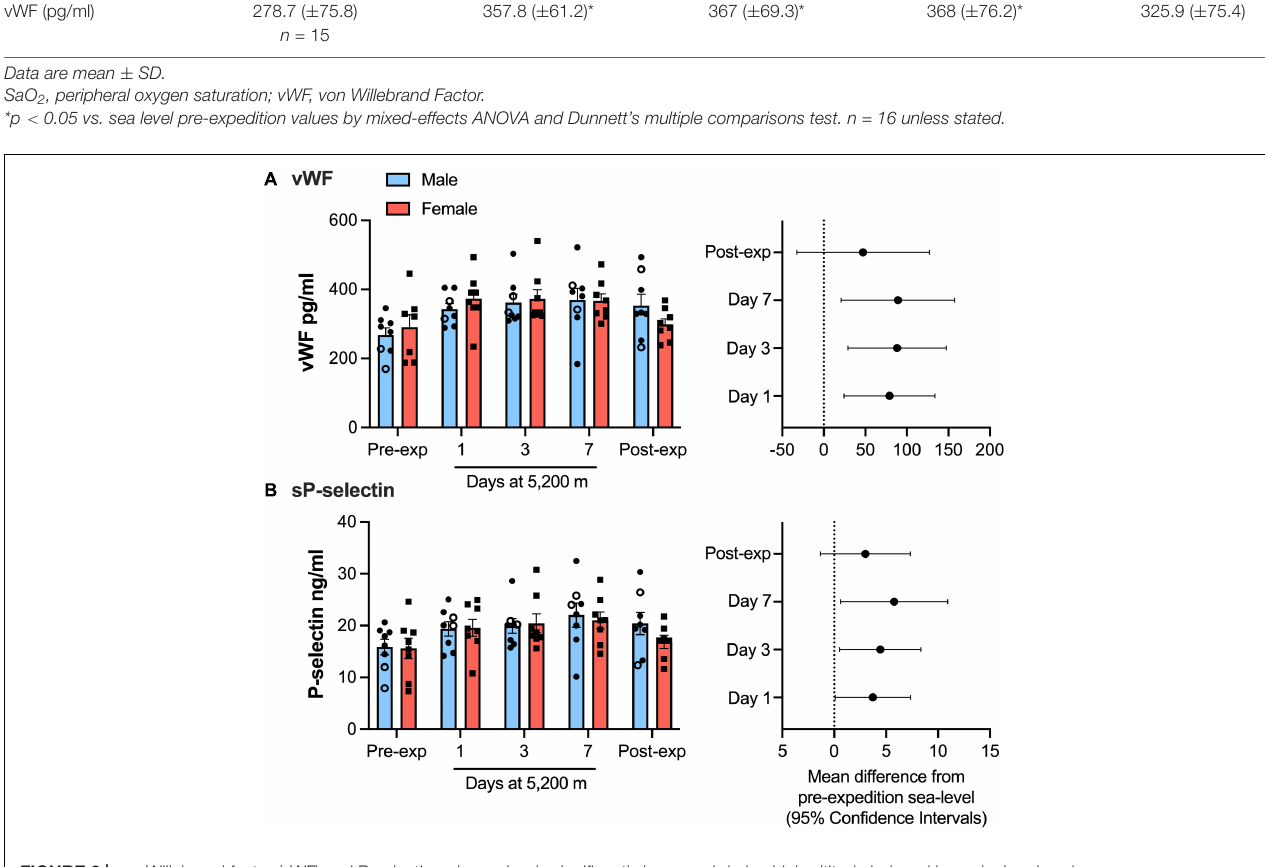
Plasma vWF significantly increased upon altitude exposure ( Figure 2 and Table 1 ) compared to pre-expedition sea-level values. sP-selectin was also significantly higher by day 1 at 5,200 m and levels of both sP-selectin and vWF remained elevated during the altitude sojourn compared to pre-expedition sea-level values ( Figure 2 ). Plasma vWF and sP-selectin were not significantly different from baseline pre-expedition levels on return to sea level, 11–16 weeks post expedition, nor was there a difference between males and females at any